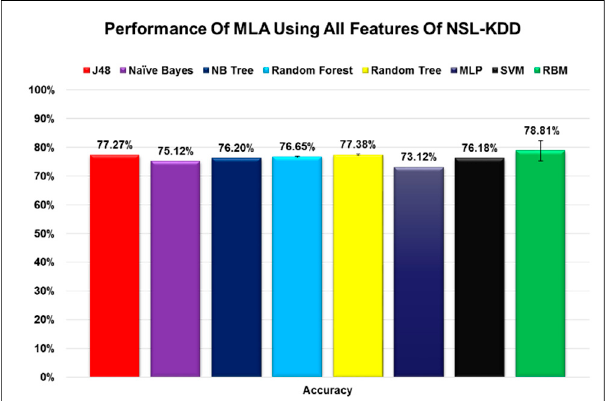
Figure 3. The performance of RBM in comparison to seven different algorithms when using all features.